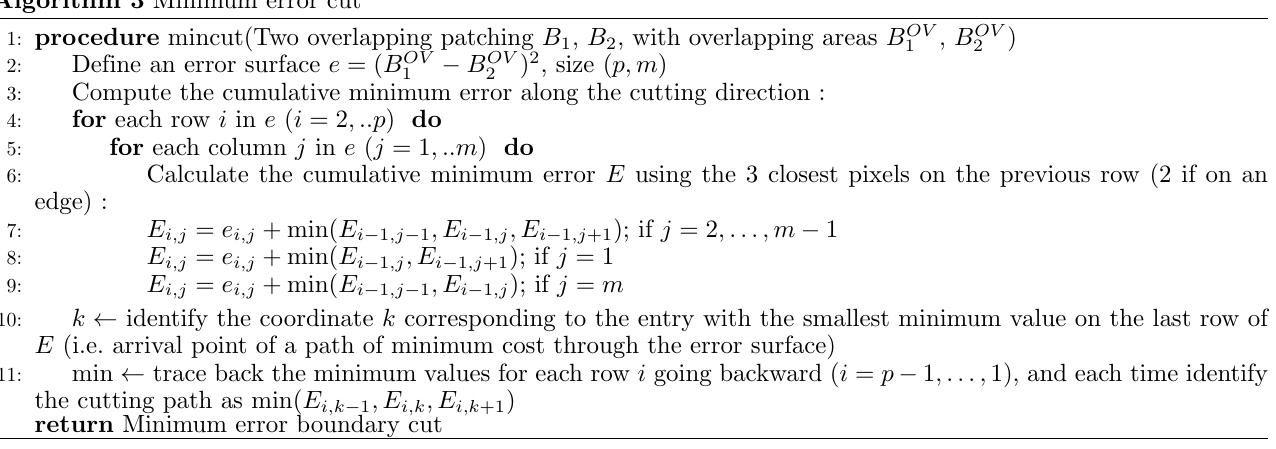
Algorithm 3 Minimum error